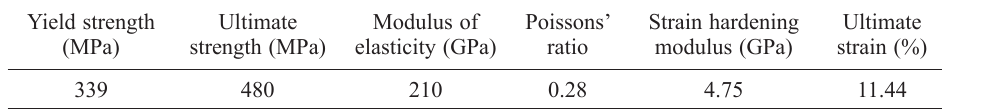
Table 2. Mechanical properties of steel tube